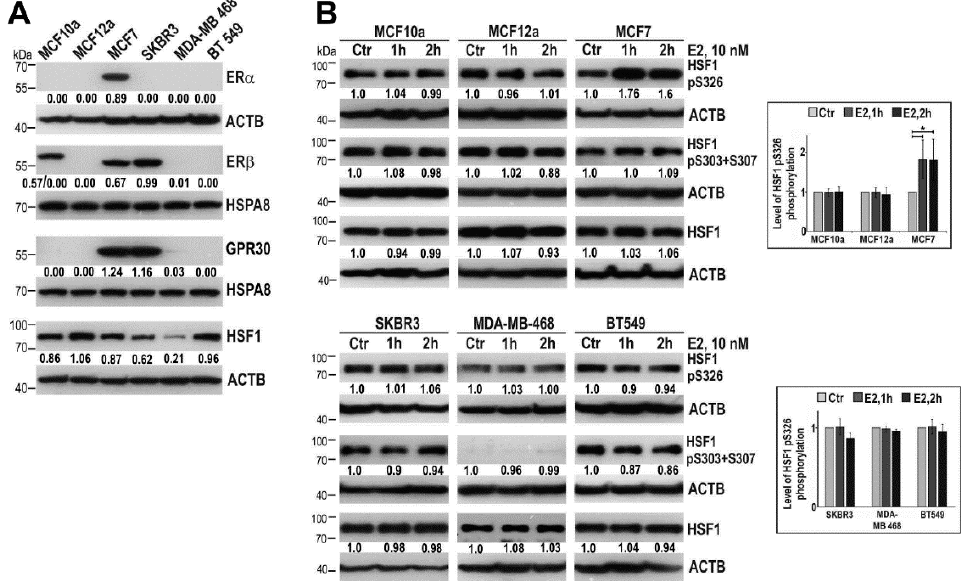
Figure 1. 17 β -estradiol (E2) induces Heat Shock Factor 1 (HSF1) phosphorylation on S326 in ERs/GPR30-positive MCF7 cells but not in ER α -negative mammary cells. ( A ) Expression of estrogen receptors, ER α , ER β , and GPR30, as well as HSF1 in human mammary non-tumorigenic (MCF10a and MCF12a) and tumorigenic (MCF7, SKBR3, MDA-MB-468, and BT549) cells. ( B ) The above cell lines were treated with 10 nM E2 for one hour or two hours and the whole-cell extracts were analyzed by western blot. The right panel shows the results of densitometric analyses. An asterisk indicates a significant difference ( p < 0.05) from the control (Ctr) value. ACTB and HSPA8 were used as controls for protein loading. Numbers below blots represent protein bands’ intensity ratios to adequate controls after normalization against ACTB.